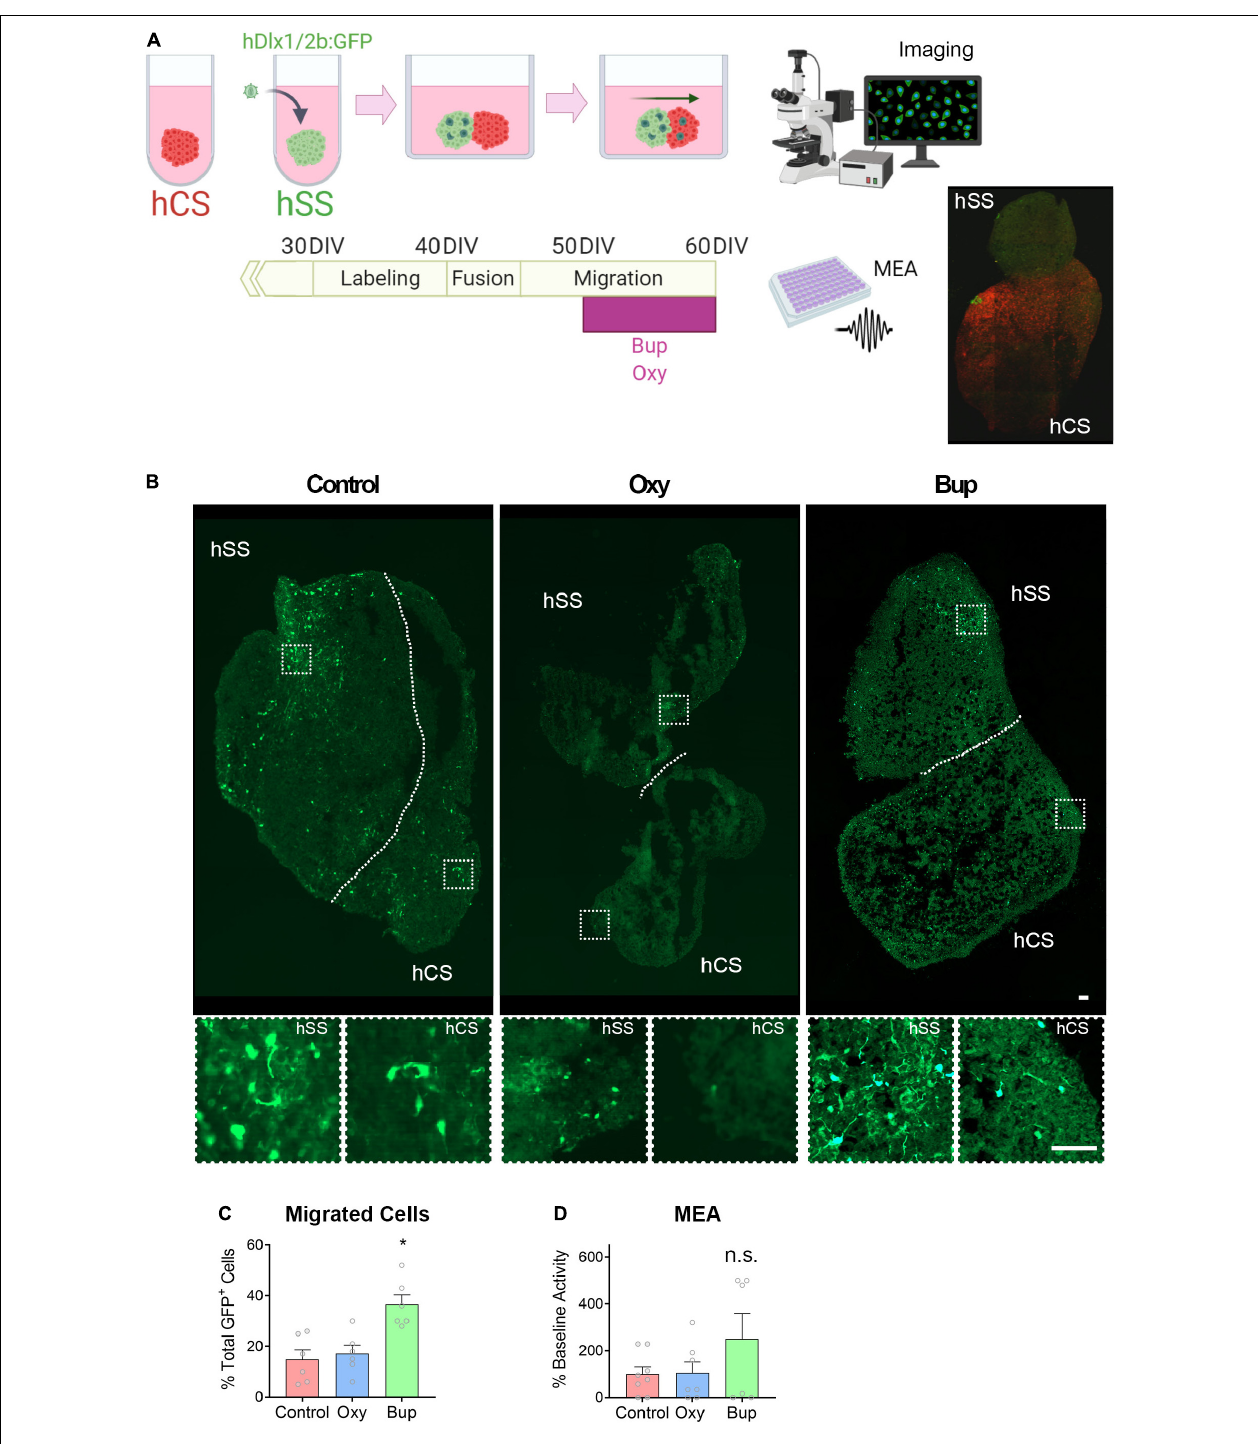
FIGURE 3 | Buprenorphine alters interneuron migration into cortical spheroids. The experimental design is depicted in (A) . Representative images of fused spheroids are shown in (B) . Buprenorphine increased the number of GFP + cells that migrated into the cortical spheroid compared to control- and oxycodone-treated spheroids, n = 6 organoids (C) . Buprenorphine exposure produces a trend toward increased network activity compared to control- and oxycodone-treated fused spheroids, n = 6-7 organoids (D) . Scale bar = 50 µ m. * p < 0.05, n.s. , no significant: DIV,days in vitro.